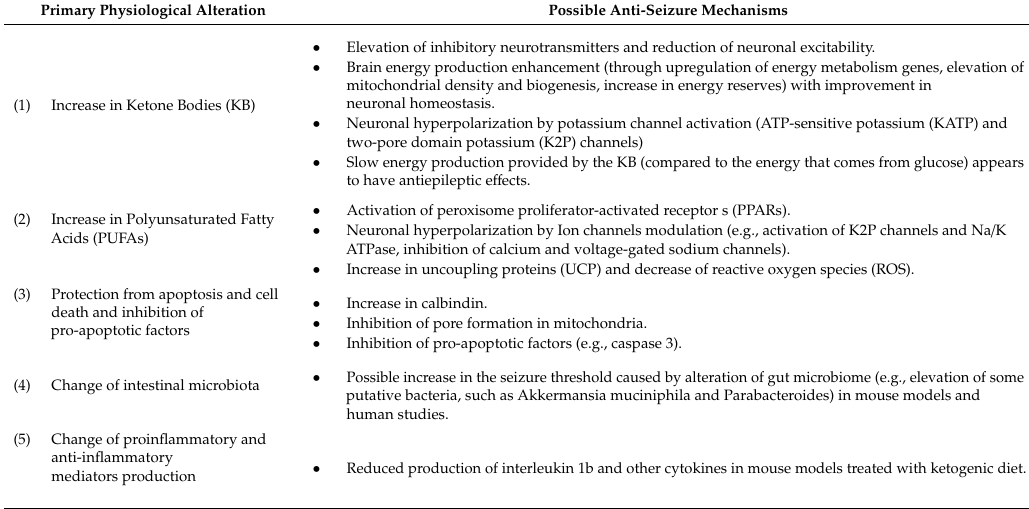
Table 2. Potential pathophysiological anti-seizure mechanisms of Ketogenic